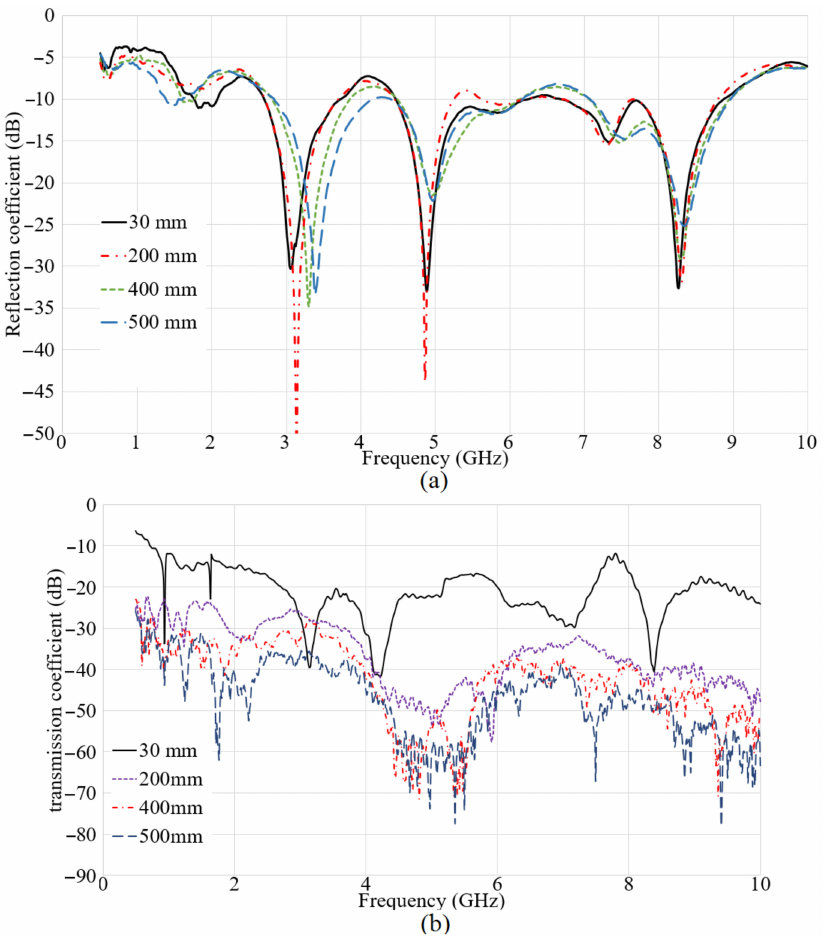
Figure 14. The reflection ( a ) and transmission coefficient ( b ) results when both antennas are at the water